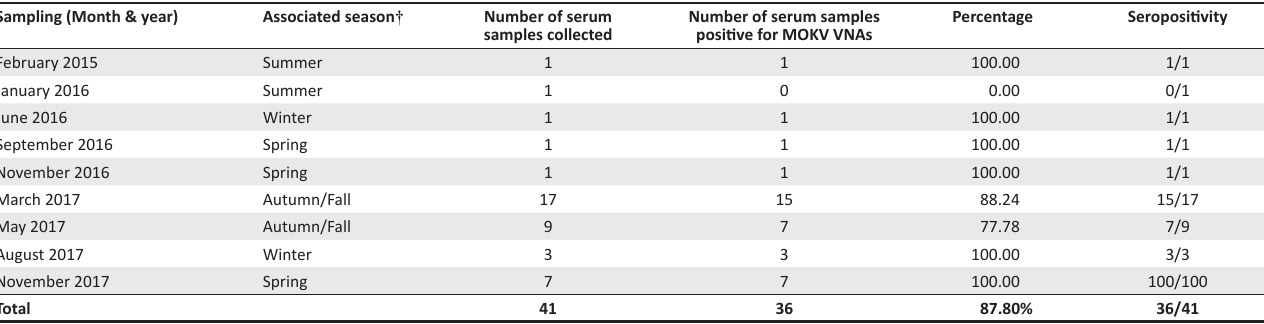
TABLE 2-A1: Sampling event details of collected Gerbilliscus leucogaster serum samples from Meletse, Limpopo province and their seropositivity. Sampling (Month &